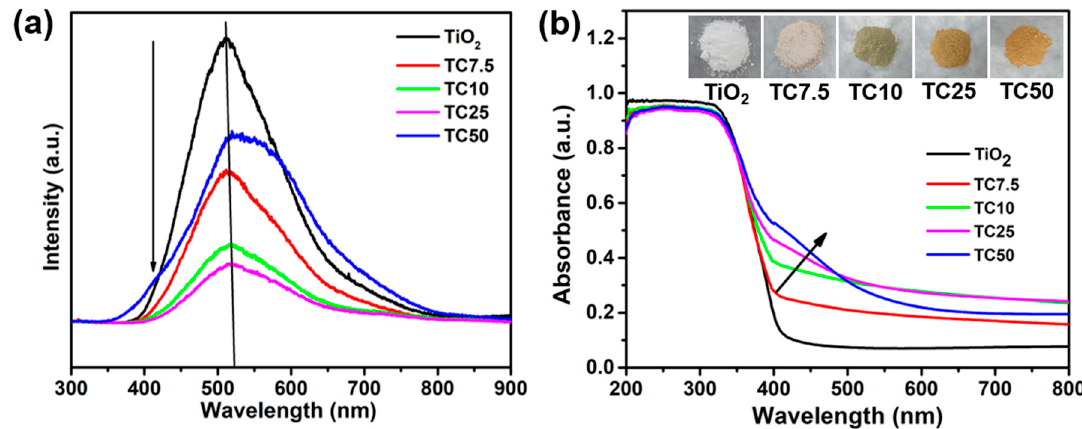
Figure 4. ( a ) PL spectra and ( b ) UV–Vis DRS spectra of pure TiO 2 P25 and synthesized materials. The energy bandgaps of the pure TiO 2 P25 and synthesized N-doped TiO 2